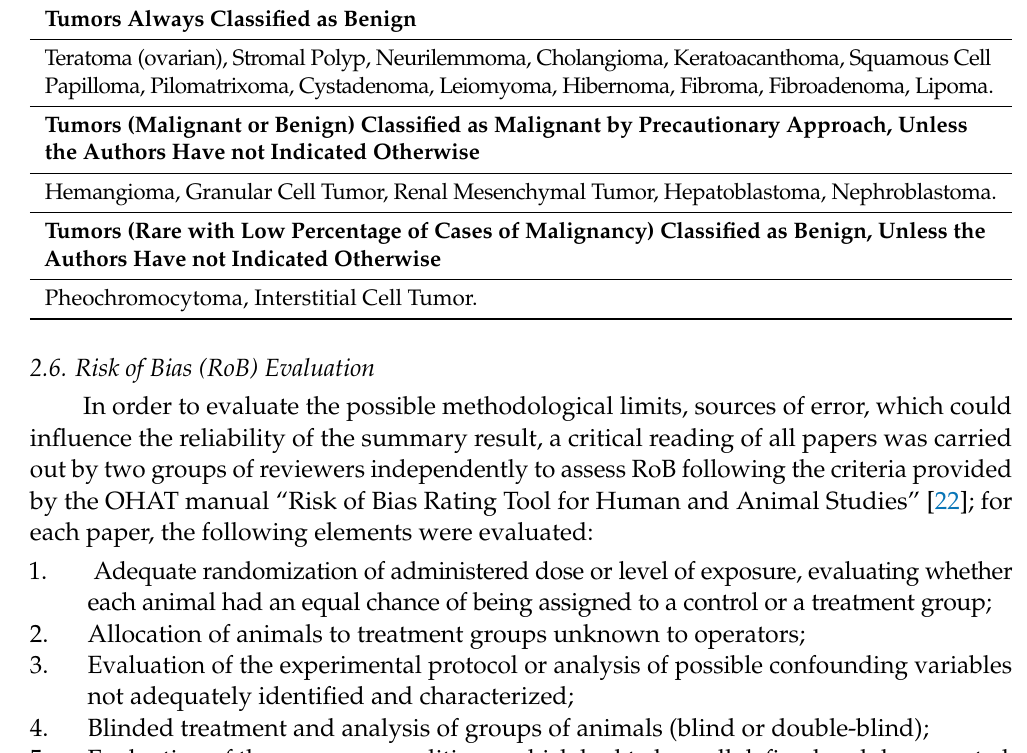
Table 1. Tumor classification (malignant tumors are omitted). Tumors Always Classified as Benign Teratoma (ovarian), Stromal Polyp, Neurilemmoma, Cholangioma, Keratoacanthoma, Squamous Cell Papilloma, Pilomatrixoma, Cystadenoma, Leiomyoma, Hibernoma, Fibroma, Fibroadenoma,